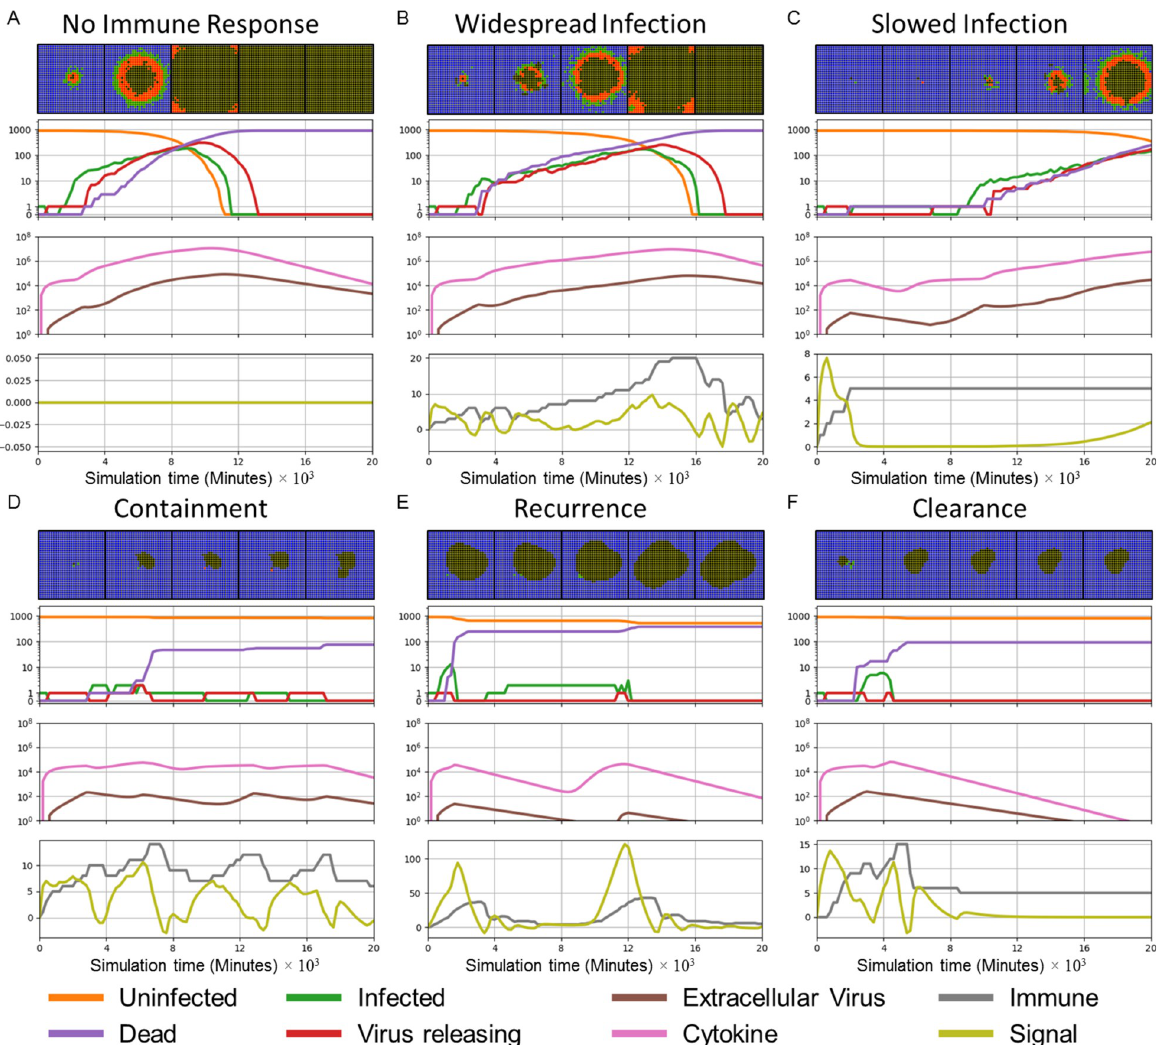
Fig 4. Patterns (classes) of spatiotemporal infection dynamics. First row: snapshots of spatial configurations of the epithelial cells. Color coded: uninfected (blue), infected (green), virus releasing (red), dead (black). TImes from left to right 4000 minutes (67 hours, 2 ¾ days), 8000 minutes (133 hours, 5 ½ days), 12000 minutes (200 hours, 8 ⅓ days), 16000 (267 hours, 11 days) and 20000 minutes (333 hours, 14 days). The right border of each snapshot aligns with the corresponding time in the time series. Second row: number of uninfected (orange), infected (green), virus- releasing (red) and dead (purple) epithelial cells vs time on a logarithmic scale (with 0 included for clarity). Third row: total extracellular cytokine (magenta) and total extracellular virus (brown) vs time on a logarithmic scale. Fourth row: value of the immune recruitment signal S (yellow) and number of immune cells (grey) vs time on a linear scale. (A) No immune response: infection propagates unopposed until all epithelial cells have died from intracellular virus. (B) Widespread infection: weak immune response slows propagation of the infection, but no uninfected cells survive at the end of the simulation. (C) Slowed infection: uninfected and infected epithelial cells coexist at the end of the simulation. (D) Containment of infection: no infected or virus-releasing epithelial cells remain, uninfected cells survive and virus remains in the extracellular environment at the end of the simulation. (E) Recurrence: the number of infected and virus releasing epithelial cells goes to zero, but persistent extracellular virus infects new epithelial cells later on. (F) Clearance: the number of infected and virus-releasing epithelial cells goes to zero and the level of extracellular virus is negligible at the end of the simulation. The model in (A) omits the immune response (components L1 , I1-I4 ). All parameter values are as in Table 1 and Fig 3 except for k on and β delay (S1 Table). Clearance: for strong immune response (small β ) and a slow infection propagation delay (small k ), the number of infected and virus-releasing epithelial cells goes to zero without on recurrence and the extracellular virus drops below a threshold (of 1/900 per cell in our analy- sis), rendering the frequency of recurrence negligible (Fig 4F). A special case of clearance